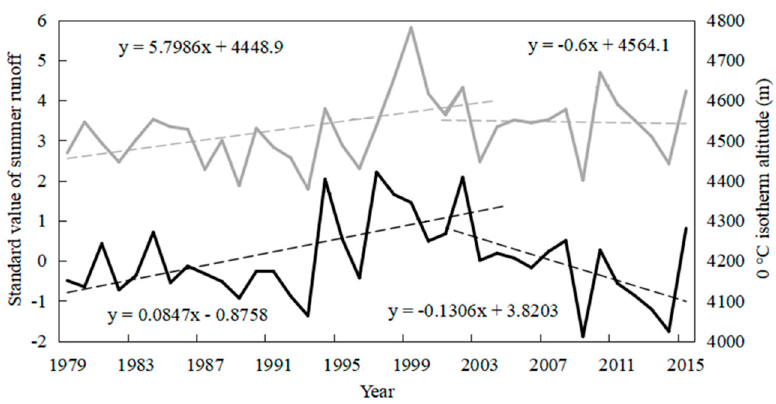
Figure 5. Annual changes in standard values of runoff in the Kumalak River (black line) and altitude of the 0 °C isotherm (grey line) in summer in the Kumalak River catchment in 1979–2002 and 2002–2015.